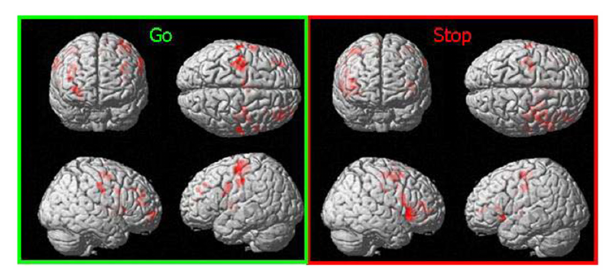
FIGURE 3 |Activation during correct responded Go-trials and successfully inhibited Stop-trials across conditions; SPM5; ROI; p < 0.05, corrected for multiple comparisons